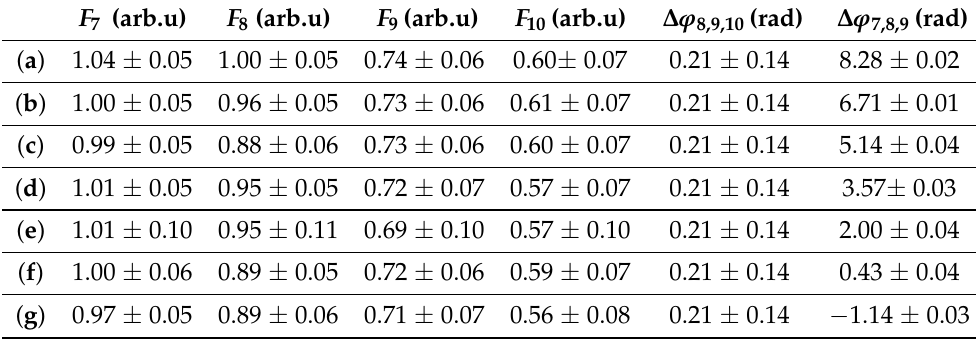
Table A2. The amplitudes( F i ’s) and the phase differences ∆ ϕ 7,8,9 and ∆ ϕ 8,9,10 for reconstructing the attosecond pulse trains presented in Figure